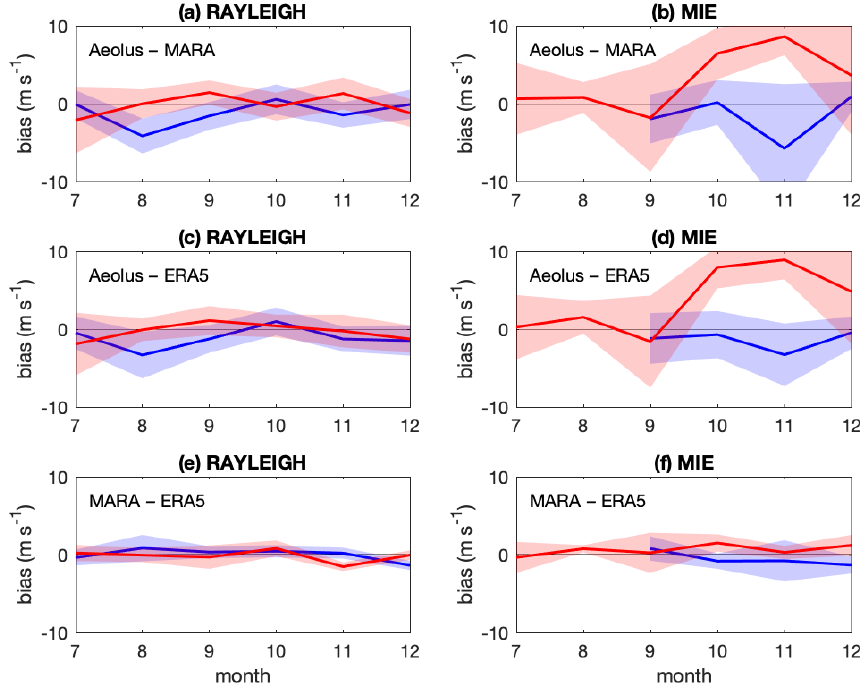
Figure 9. Month-by-month mean values of biases in HLOS winds (solid lines) and 90% confidence limits (shaded areas) at MARA. Red is for ascending tracks and blue is for descending ones. (a) Aeolus Rayleigh minus MARA, (b) Aeolus Mie minus MARA, (c) Aeolus Rayleigh minus ERA5, (d) Aeolus Mie minus ERA5, (e) MARA minus ERA5 at available Aeolus Rayleigh comparison times/heights and (f) MARA minus ERA5 at available Aeolus Mie comparison times/heights.